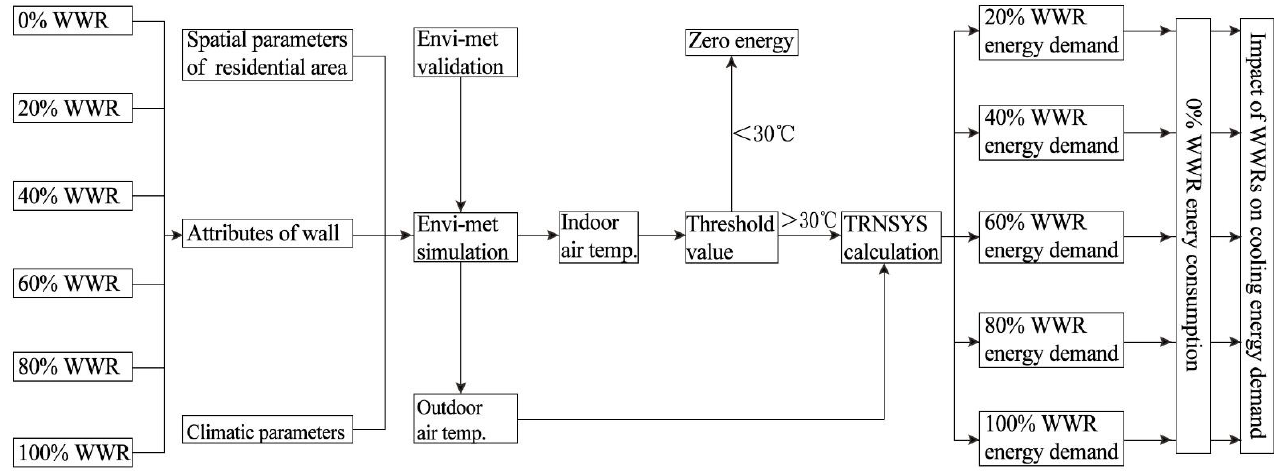
Figure 5. The technical framework of the study.